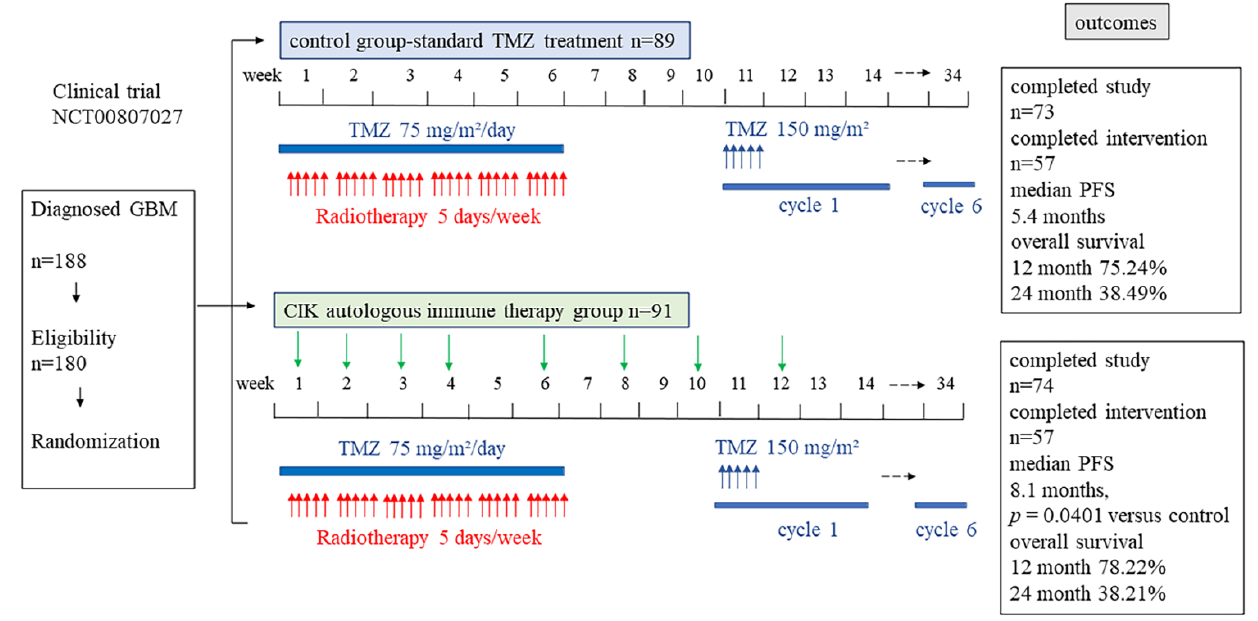
Figure 3. A schematic picture shows the clinical trial NCT00807027, including the study design, randomization, and outcomes.